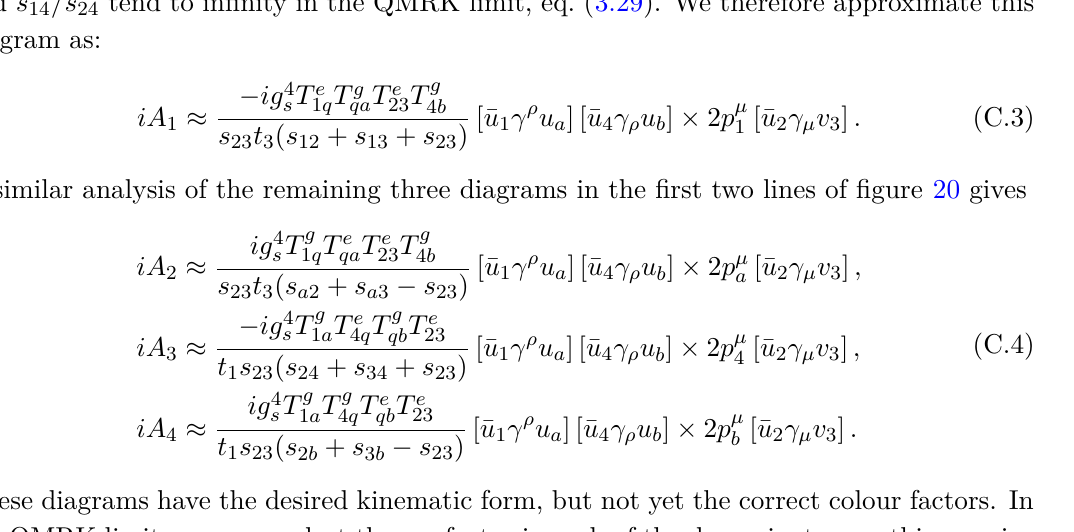
Figure 20. All Feynman diagrams which contribute to q ˜ q → qQ In this equation the spinors relating to p